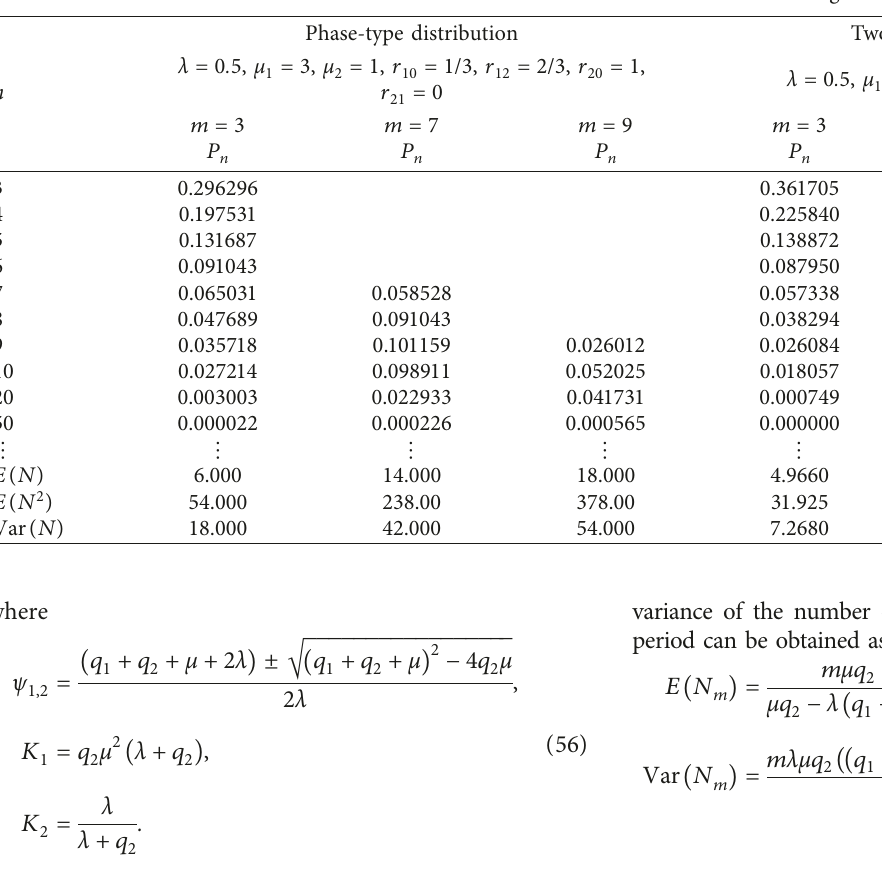
Table 4: Distribution of the number of customers served during a busy period.